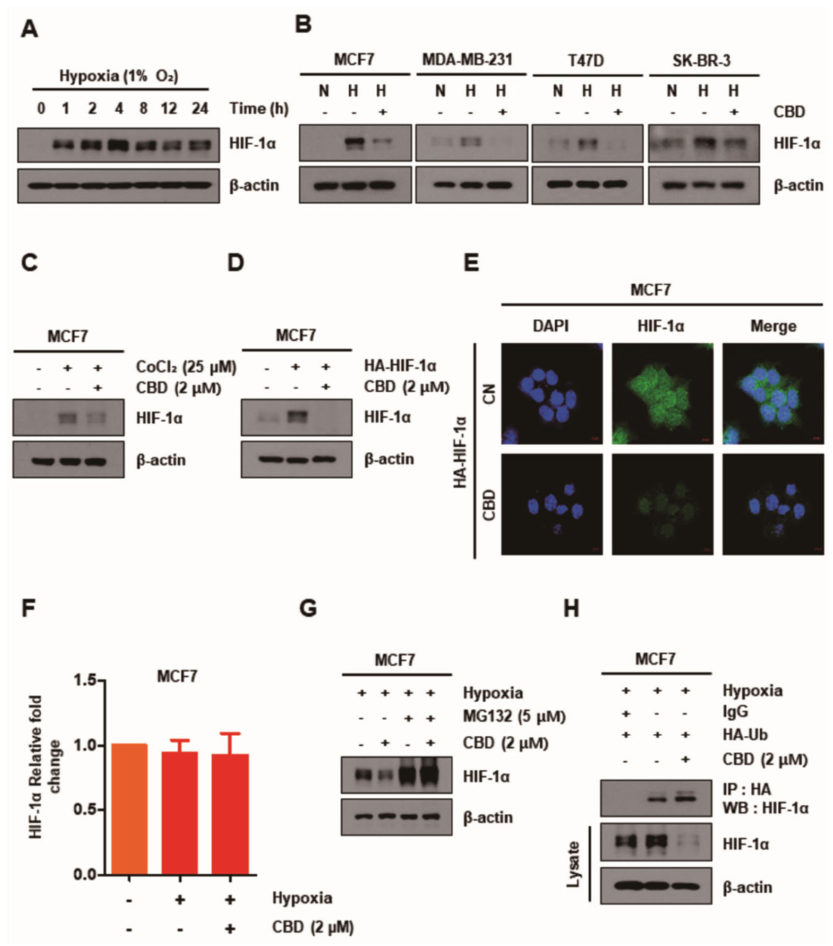
Figure 2. CBD decreases HIF-1 α by post-transcriptional levels of HIF-1 α regulating the ubiquitin proteasome (UPS) system. ( A ) MCF7 cells were treated with CBD (2 µ M) for different time periods in hypoxia conditions. The expression of HIF-1 α detected by Western blotting was significantly increased after 4 h. ( B ) Breast cancer cell lines were treated with CBD (2 µ M) for 24 h. The protein level of HIF-1 α was detected by Western blotting. ( C , D ) MCF7 cells were chemically induced with CoCl 2 (25 µ M) or transfected with HA-HIF-1 α plasmid. Then, cells were treated with CBD (2 µ M) for 24 h in normoxia conditions. The protein level of HIF-1 α was detected by Western blotting. ( E ) MCF7 cells were transfected with HA-HIF-1 α plasmid and then treated with CBD (2 µ M) in normoxic conditions. Immunofluorescence images showed the expression of HIF-1 α . ( F ) The mRNA level of HIF-1 α was measured by qRT-PCR. ( G ) MCF7 cells were pretreated with proteasome inhibitor (MG132) (5 µ M). After 1 h pretreatment, the cells were treated with CBD (2 µ M) for 24 h. The protein level of HIF-1 α was detected by Western blotting. β -actin was used as a loading control. ( H ) MCF7 cells were transfected with HA-Ub plasmid and then treated with CBD (2 µ M) for 24 h. HIF-1 α was isolated by immunoprecipitation with IgG and anti-HA antibody, followed by immunoblotting for HIF-1 α ; total HIF-1 α and β -actin protein levels were detected by Western blotting. CBD; cannabidiol, CN; control, N; normoxia, H;